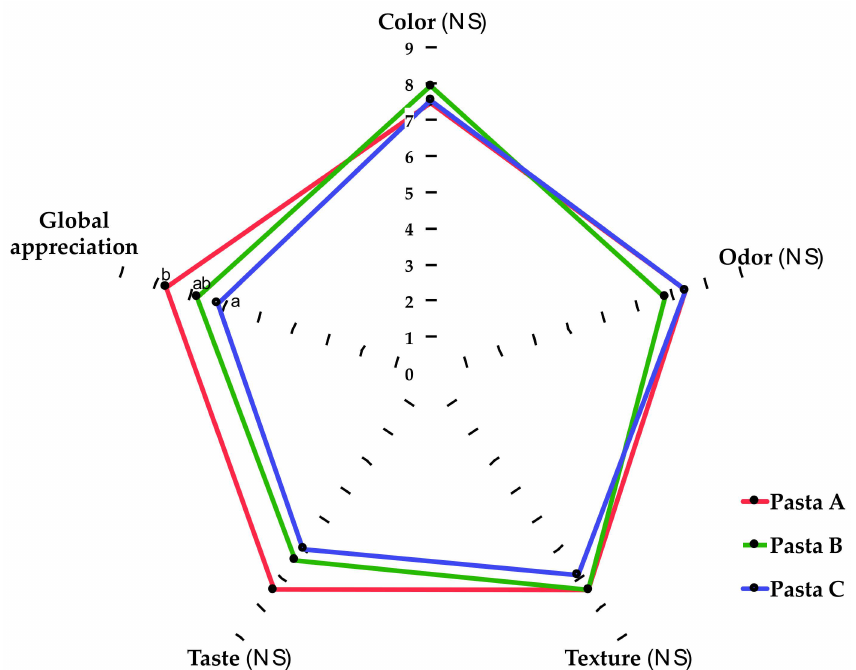
Figure 2. Sensory evaluation of cooked pasta. A hedonic scale was used, where 0 = totally dislike and 10 = like very much. Comparisons in each sensory attribute were carried out using ANOVA and Tukey tests. Di ff erent letters indicate statistical di ff erence ( p < 0.05). NS: nonsignificant di ff erence.